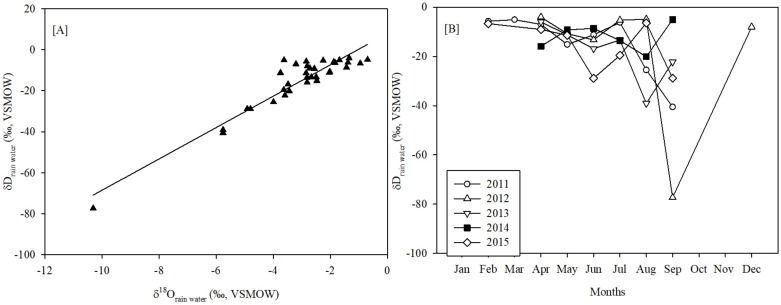
Isotopic variation of modern regional precipitation (IsoGSM2).(A) Local meteoric water line in the Banni region has been obtained using cross-plot between δD and δ18O values. (B) The monthly averaged δD values of precipitation become progressively depleted in heavier isotope with the establishment of the ISM.